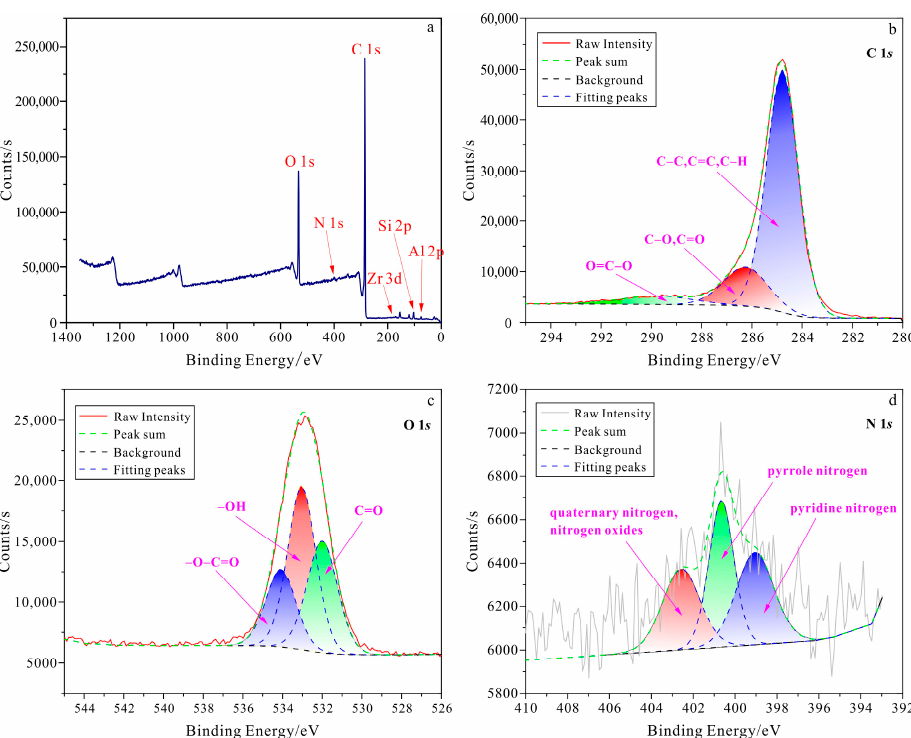
Table 3. Peak-fitting results of C 1s scan spectrum. Figure 4. ( a ) X–ray photoelectron spectroscopy wide scan; ( b ) C 1s scan; ( c ) O 1s scan; ( d ) N 1s scan of the FK–3